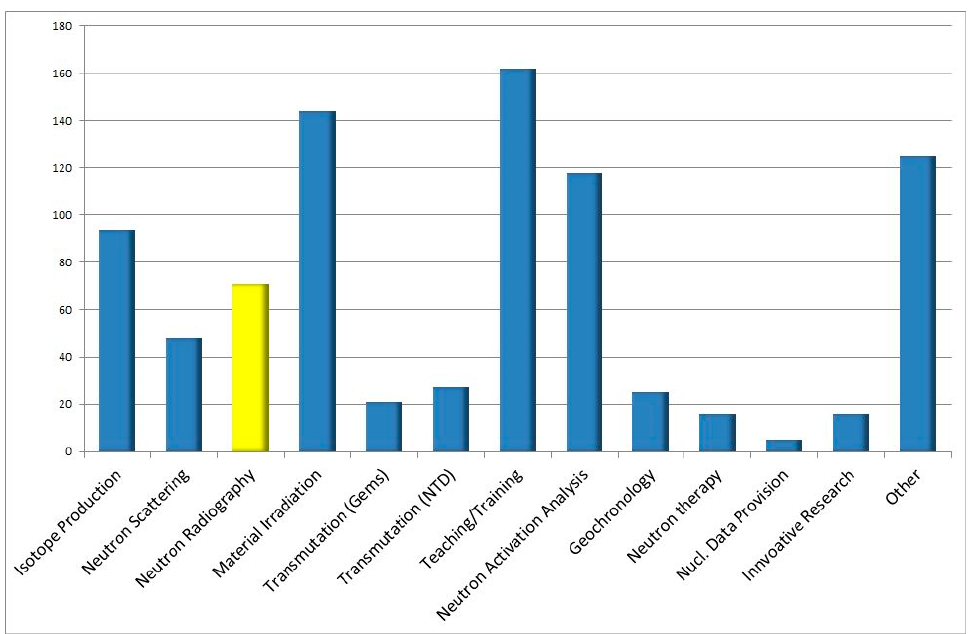
Figure 6. Utilization of operational research reactors according to the declaration by the facilities’ managers fixed in the Research Reactor Data Base (RR DB) [15].